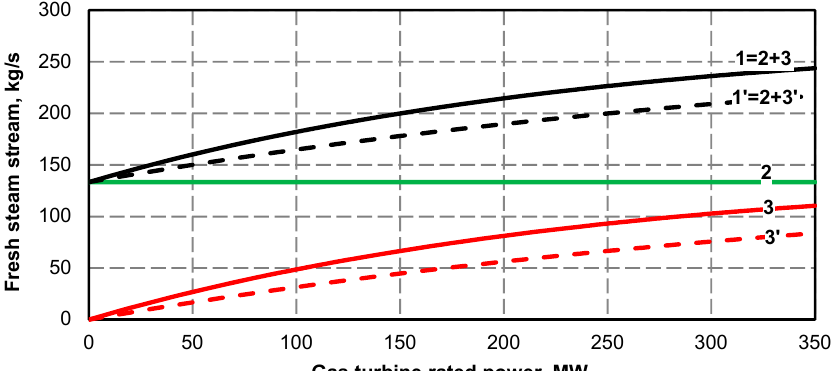
Figure 25. Fresh steam streams as a function of gas turbine rated power at a minimum steam boiler output of 133.3 kg/s: 1, 1’ — steam streams fed to the steam turbine, 2 — steam stream generated in the steam boiler at its minimum output, 3 — steam stream generated in the recovery boiler for gas turbine operating at its rated power, 3’ — steam stream generated in the recovery boiler for gas turbine operating at 60% of its rated power.